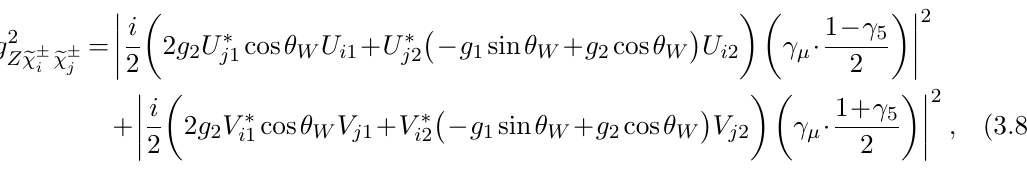
(cid:31) 0 ! (cid:31) 0 Z ) as a function of the e e 2 1 (cid:31) (cid:6) - (cid:31) (cid:6) mass di(cid:11)erence. The colour map corresponds to the wino component e e 1 2